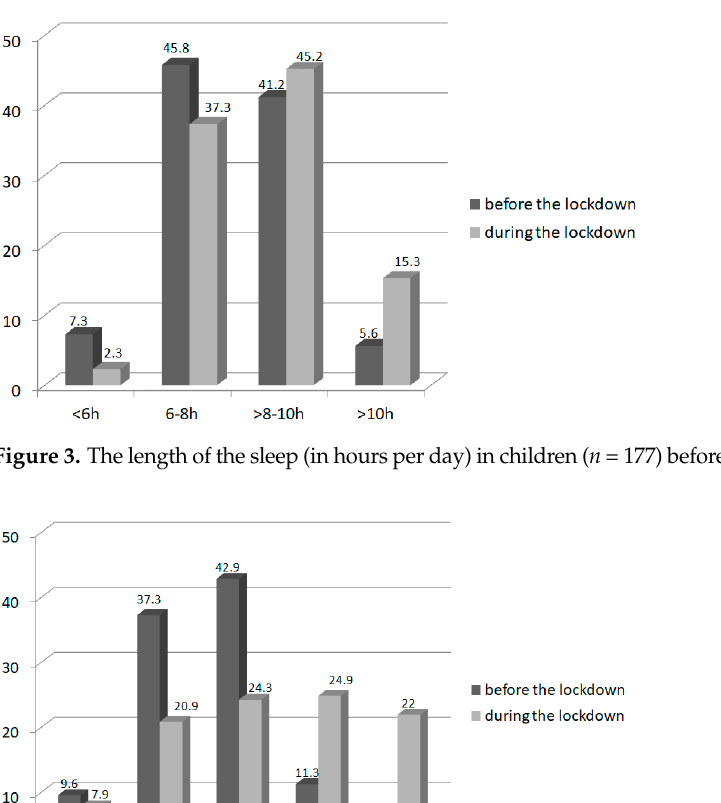
down ( p < 0.001); Figure 4).